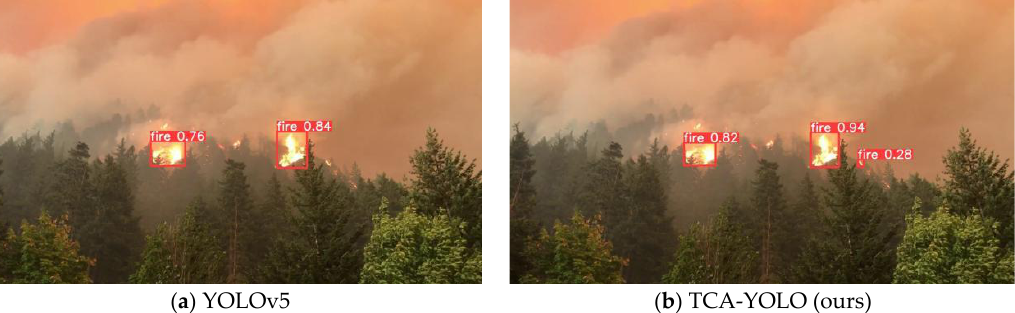
Figure 14. Comparison of the detection effect of YOLOv5 and TCA-YOLO. ( a ) YOLOv5’s performance in detecting small fire points. ( b ) Our model’s performance in detecting small fire